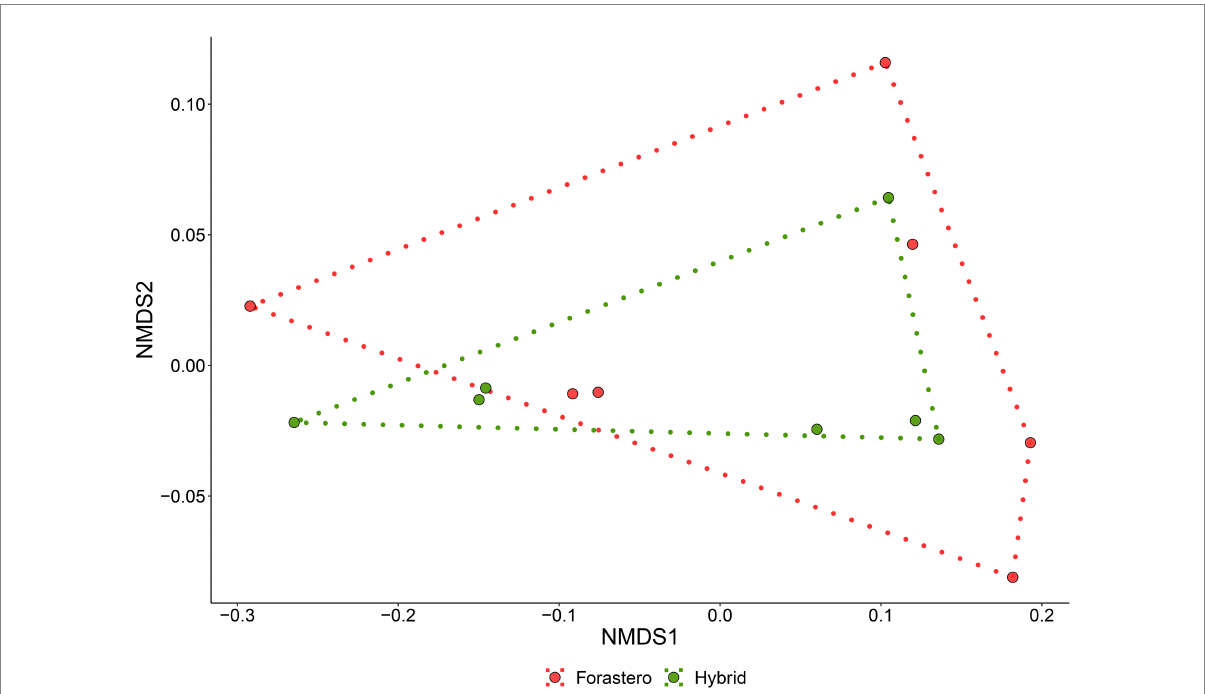
FIGURE 1 Permutational Dispersion plot of cocoa varieties samples in distinct fermentation times. Black circles for FOR (Forastero) and red triangles for MIX (mixture of two cocoa beans hybrid